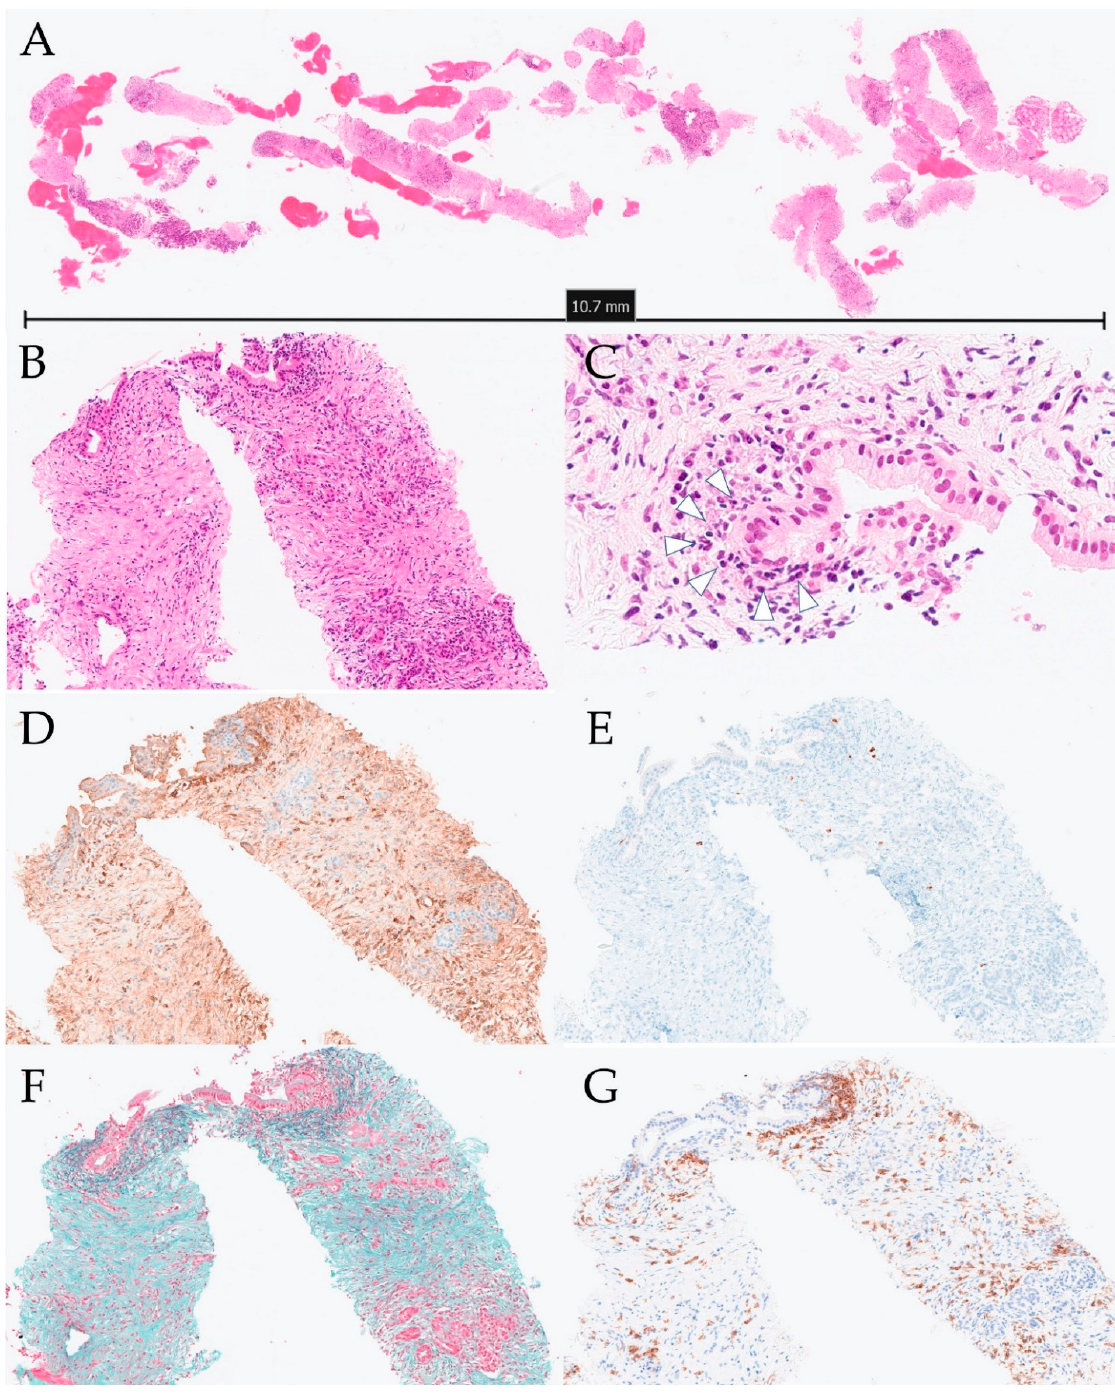
Figure 4. Histopathological tissue from case 10 obtained using EUS-FNB. ( A ) Loupe image of specimen obtained using EUS-FNB showing adequate amount of tissue (hematoxylin–eosin stain) ( B ) Microscopic image showing neutrophilic infiltration of pancreatic parenchyma (hematoxylin–eosin stain, ×10). ( C ) Microscopic image showing GELs (arrowhead, hematoxylin–eosin stain, ×40). ( D ) IgG immunostaining showing IgG-positive cells (×10). ( E ) IgG4 immunostaining showing a few IgG4-positive cells (×10). ( F ) Elastica–Masson staining showing no obstructive phlebitis (×10). ( G ) Cluster of differentiation 38 immunostaining showing plasma cells (×10).